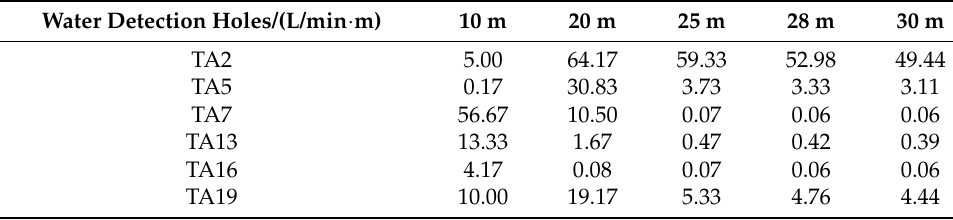
Table 11. Water inflow of ZD DK365+280 to +250 (0.3